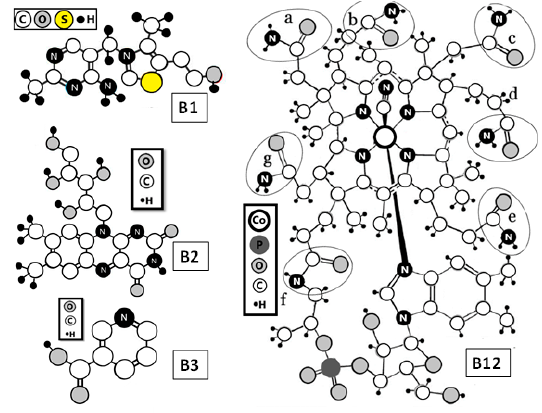
Figure 3. Molecular structure of vitamins B1, B2, B3, and B12.